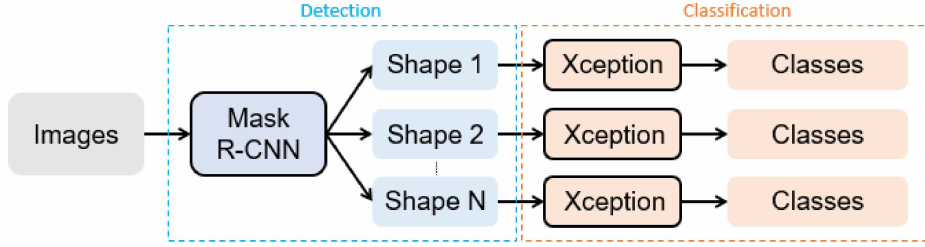
Figure 5. The framework of our proposed approach.